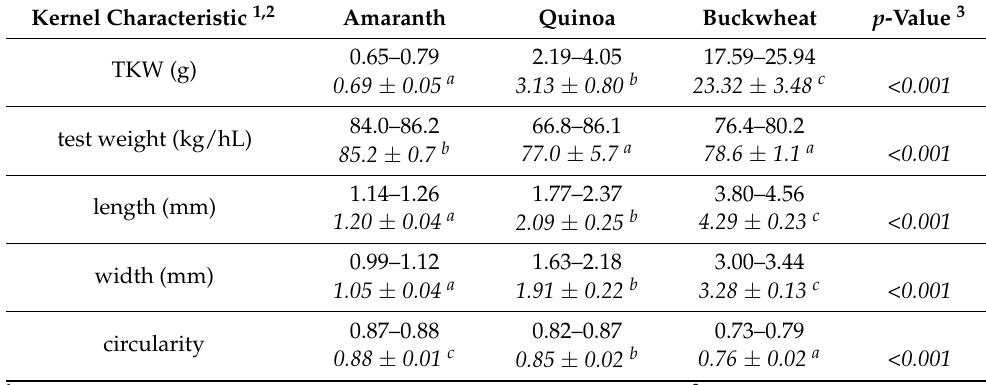
Table 2. Characteristics of amaranth ( n = 8), quinoa ( n = 7) and buckwheat ( n = 10) seeds. Kernel Characteristic